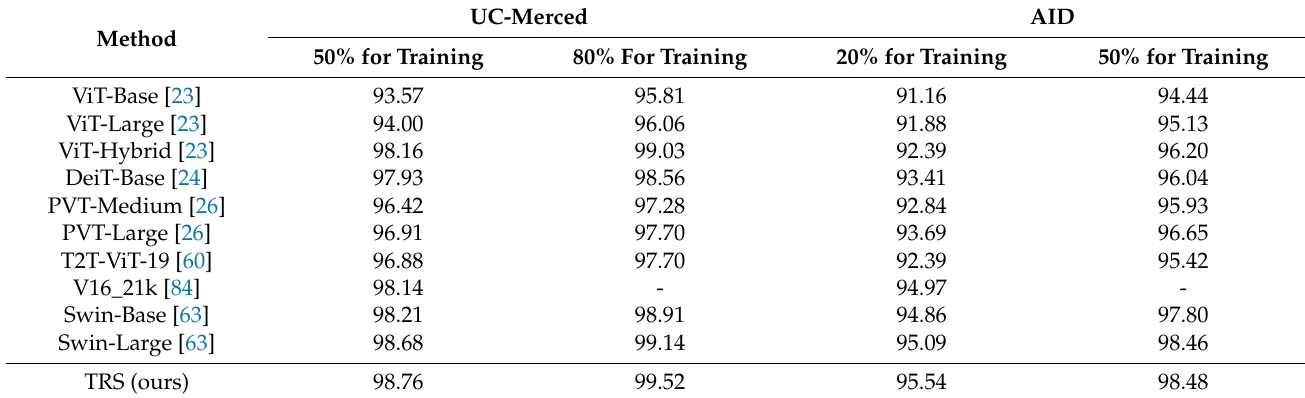
Table 8. Comparison with other Transformers on UC-Merced and AID.